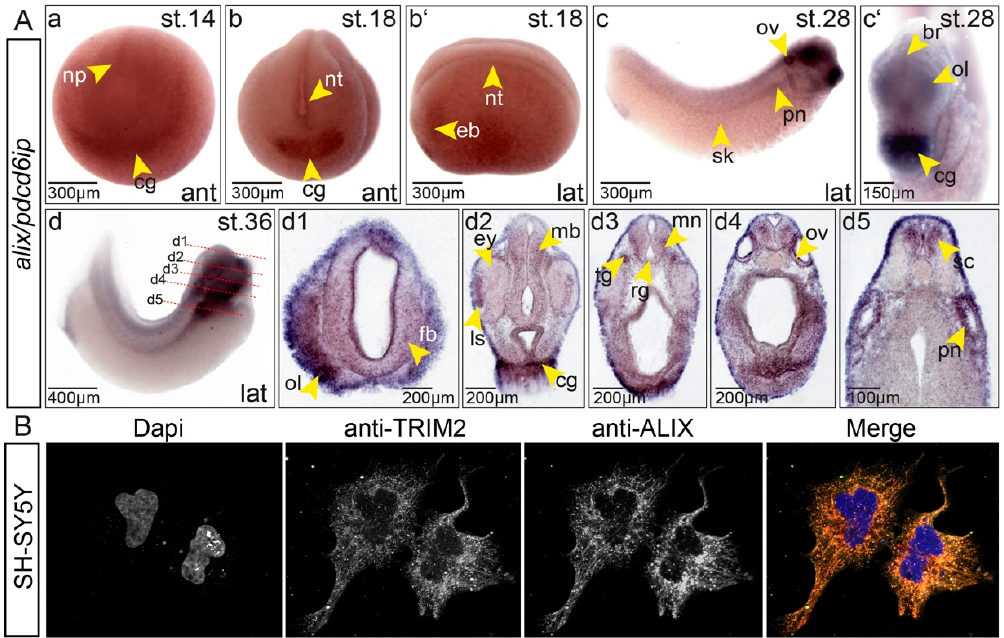
Figure 6. ( A ) Expression of alix during neurogenesis overlaps strongly with trim2 in Xenopus . (a) At NF stage 14, alix expression was observed within the neural plate (np) and cement gland Anlage (cg). (b–b’, anterior (ant) and lateral (lat) views) At NF stage 18, alix transcripts were detected in the neural tube (nt), eye vesicle (ev), and forming cement gland (cg). (c–c‘) At NF stage 28, the presumptive brain (br), olfactory placode (ol), otic vesicle (ov), cement gland (cg), pronephros (pn), and skin cells (sk) reveal alix transcripts. (d) At NF stage 36, a lateral view showed strong expression in eye, embryonic brain, spinal cord (sc), otic vesicle, and pronephros. (d1–d5) Twenty-micrometer transverse gelatine/albumin sections taken at the level of fore-, mid-, hindbrain, otic vesicle, and spinal cord. Transcripts of alix were detected in the eye (ey), forebrain (fb), midbrain (mb), hindbrain, lens epithelium (ls), motor neuron (mn), olfactory pit (olp), otic vesicles (ov), radial glial cells (rg), spinal cord (sc), and trigeminal nerve (tg). ( B ) Endogenous Alix and Trim2 were detected by fluorescence immunohistochemistry in a strongly overlapping pattern within the cytoplasm of SH-SY5Y glioblastoma cells. Pictures were taken in gray-scale. Merge in false colors. Nuclei were stained with DAPI (blue).